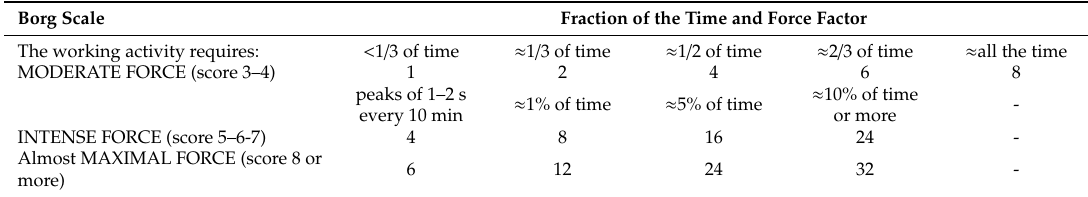
Table 3. Force factor score using the “fraction of the time” and the Borg scale. Borg Scale Fraction of the Time and Force